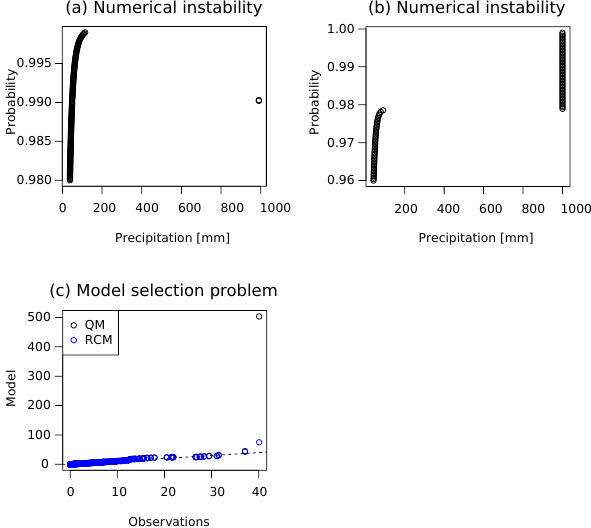
Figure A1. Examples of problems with the mixture model. (a) Nu- merical instability: discontinuous cdf; (b) numerical instability: cdf that jumps to the upper bound of 1000mmday − 1 and does not jump back as in (a) , and (c) problematic model selection: QQ plot of a selected mixture model that fits well for most quantiles but corrects the extremes to too